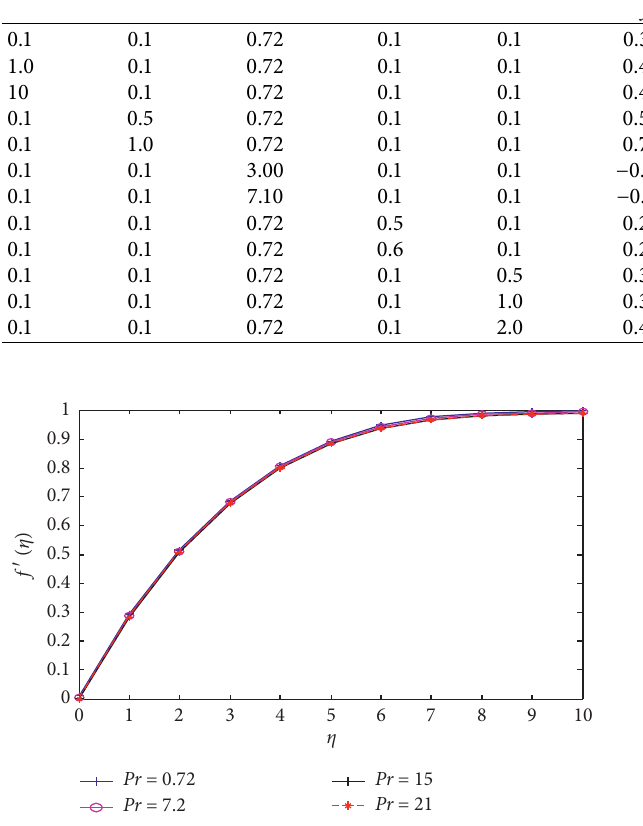
Figure 2: Velocity profiles for various values of the Biot number ( Bi ) when Pr � 0.72, Gr � 0.1, M � 0.1, λ � 0 . 1, and, Ra �